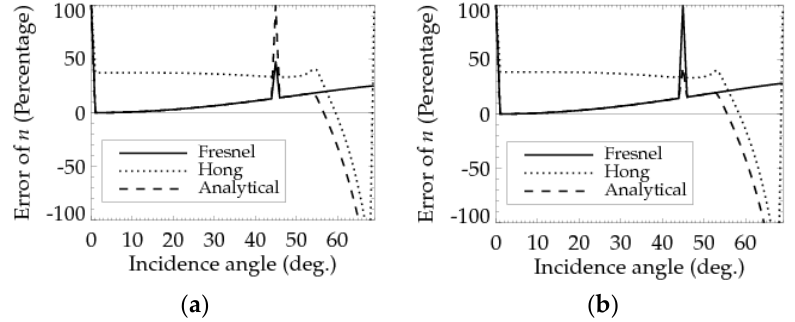
Figure 11. Error (%) in the retrieved refractive index ( n ) for ( a ) soil at 0.56 μ m and ( b ) water at 0.4 μ